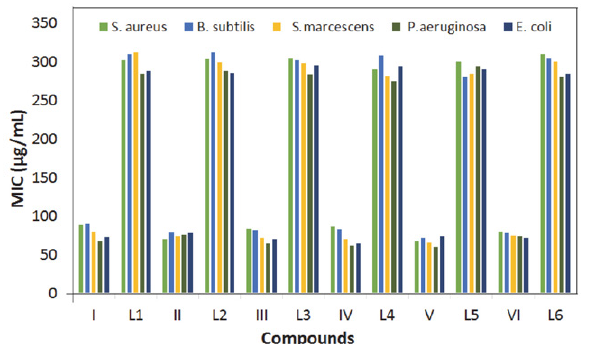
Figure 3. Cellular level cytotoxicity of synthesized compounds us- ing S. cerevisiae, dead cells are seen dark whereas live cells are seen transparent.